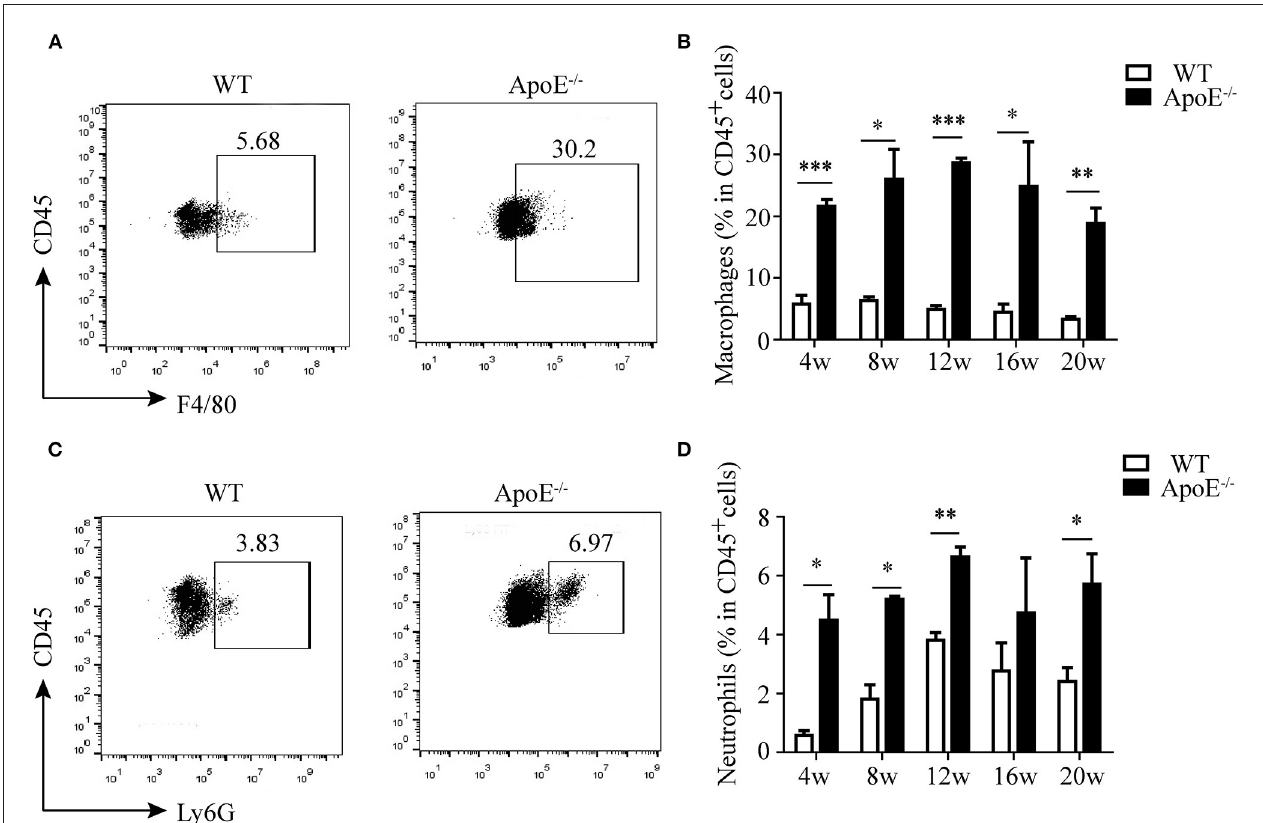
FIGURE 3 | Infiltration of innate immune cells in the aorta. (A) Representative dot plots of F4/80 + macrophages gating on CD45 + leukocytes in the aorta of wild-type (WT) and ApoE − / − mice fed with high-fat diet (HFD) for 12 weeks. (B) Percentage of macrophages in the aorta of WT and ApoE − / − mice fed with HFD at different time points (4–20 weeks). (C) Representative dot plots of Ly6G + neutrophil gating on CD45 + leukocytes in the aorta of WT and ApoE − / − mice fed with HFD for 12 weeks. (D) Percentage of neutrophils in the aorta of WT and ApoE − / − mice fed with HFD at different time points (4–20 weeks). Each group consisted of six mice. * p < 0.05, ** p < 0.01, *** p <